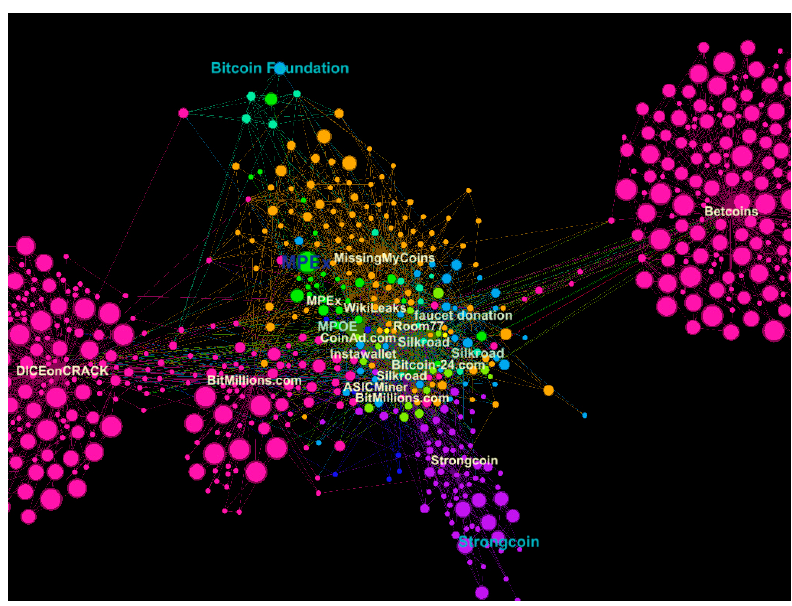
Figure 38. Visualization of the Transaction Value in the Bitcoin Network.